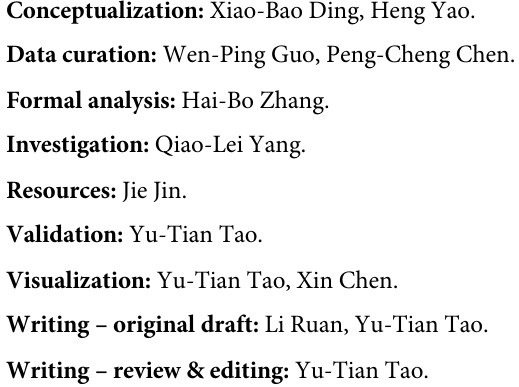
S1 Fig. The receiver operating characteristic curves of 15 feature values. The 15 features with areas under the curve above 0.6 were selected for use in functional gene association pre- diction. (JPG) S1 Table. Number of protein interactions and their component proteins collected from IntAct and BioGrid. S2 Table. Functional association evidence data and the methods used to compute feature values from these data. S3 Table. Assessment of feature qualities. S4 Table. Functional annotations reported by MID/GSLA for the top 250 transcriptionally changed genes between the Olfm4 mutant and wild type. S5 Table. Functional annotations reported by DAVID for the top 250 transcriptionally changed genes between the Olfm4 mutant and wild type. S6 Table. Functional annotations reported by GO enrichment analysis tool for the top 250 transcriptionally changed genes between the wild type and Piezo1- knockout mice. S7 Table. Functional annotations reported by DAVID for the top 250 transcriptionally changed genes between the wild type and Piezo1 -knockout mice. S8 Table. Functional annotations reported by MID/GSLA for the top 250 transcriptionally changed genes between the wild type and Piezo1 -knockout